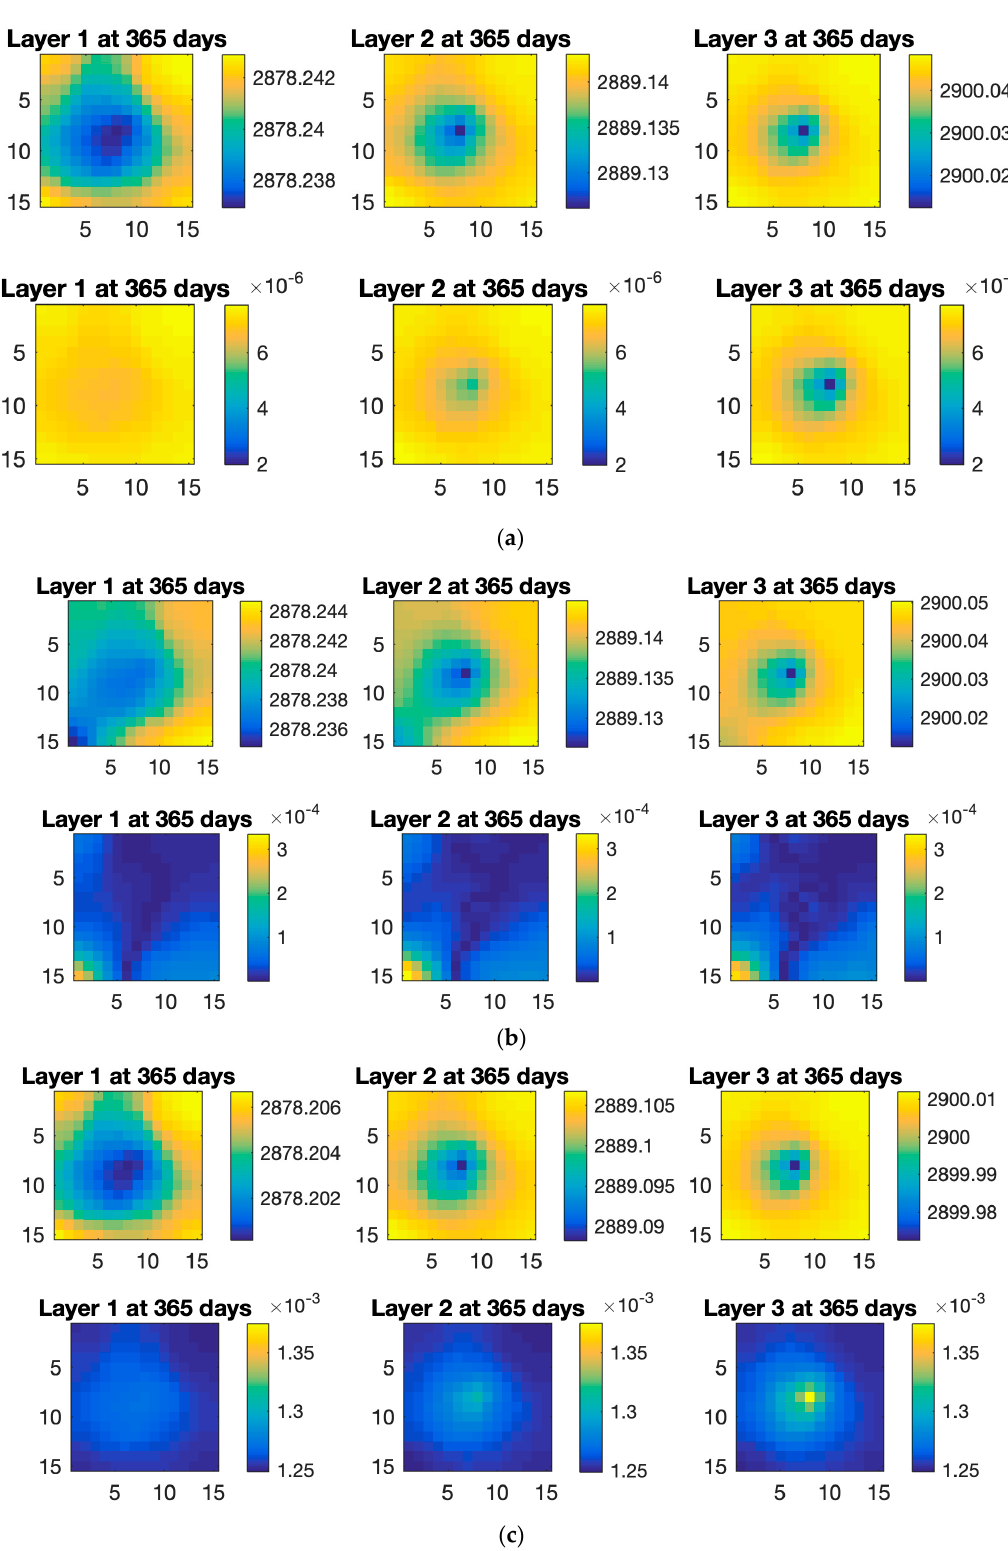
Figure 7. Results of reduced-order model with different methods, within each group of ( a – c ) the upper one is pressure map and the lower one is error map. ( a ) Online sparsity DMD with five basis (first row = pressure maps; second row = error maps); ( b ) Online proper orthogonal decomposition (POD) with 5 basis (first row = pressure maps; second row = error maps); ( c ) Offline sparsity DMD with 24 basis (first row = pressure maps; second row = error maps). Table 1. Computation time of solver with different model order reduction (MOR) method.